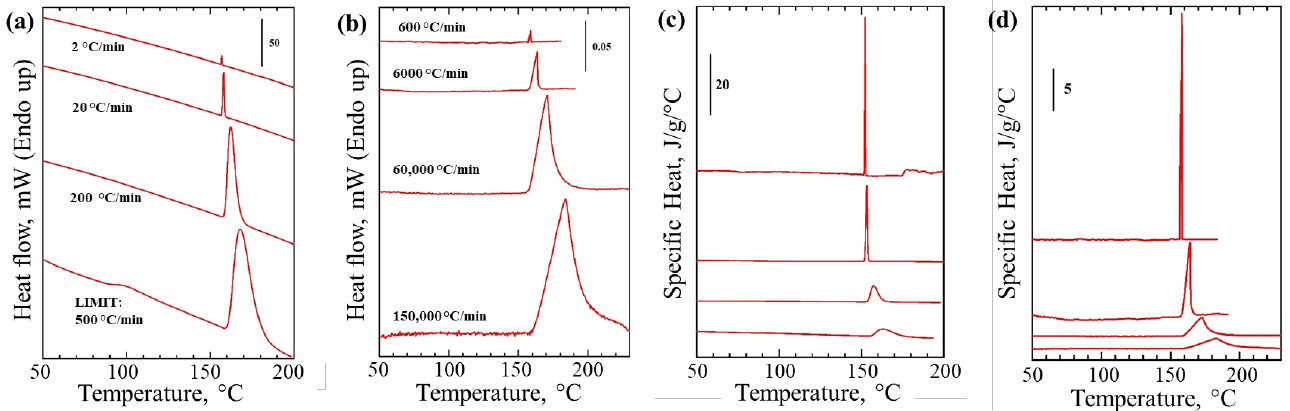
Figure 3. Up to × 100 fold faster scanning rates achieved using thermal nano-analyzer. Melting of indium using DSC and thermal nano-analyzer instruments. Heat flow vs. sample temperature recorded with the help of conventional DSC with 5.76 mg In sample ( a ) and thermal nano-analyzer instrument using 42 ng In particle deposited on the gas sensor ( b ). Heating rates used for each curve are indicated on the graphs. the maximum scanning rate achievable by commercial instrument was 500 °C/min. Two orders of magnitude increase in scanning rate and sensitivity are achieved with the thermal nano-analyzer instrument. Specific Heat vs. sample temperature for DSC ( c ) and thermal nano-analyzer ( d ) were calculated by correcting for heating rate and sample weight.